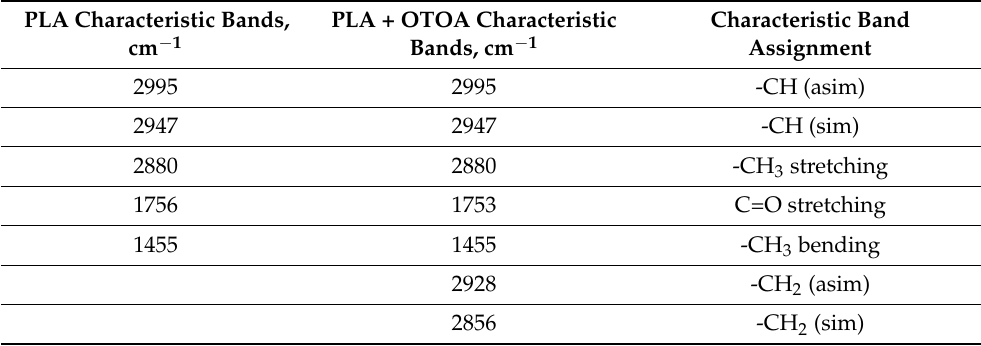
Table 1. Characteristic bands in the FTIR spectra for pristine PLA and PLA + OTOA films. Characteristic Band PLA + OTOA Characteristic PLA Characteristic Bands, Assignment Bands, cm − 1 cm − 1 2995 2995 -CH (asim) 2947 2947 -CH (sim) 2880 2880 -CH 3 stretching 1756 1753 C=O stretching 1455 1455 -CH 3 bending 2928 -CH 2 (asim) 2856 -CH 2